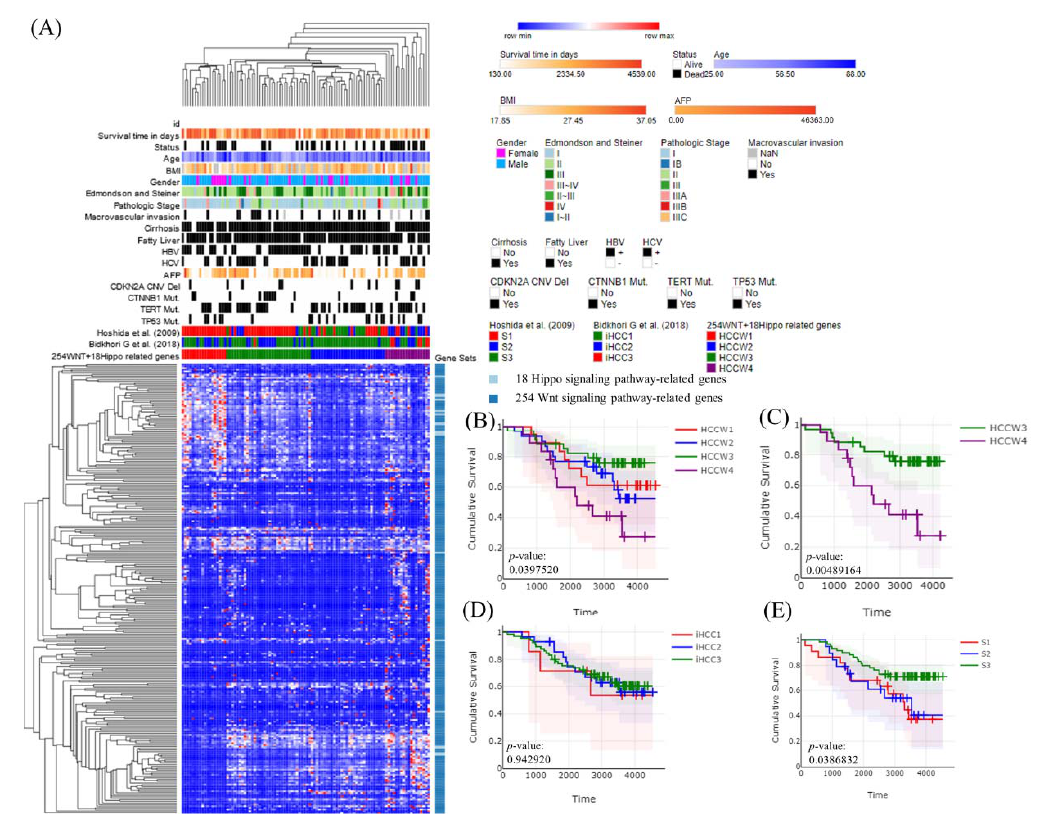
Figure 3. Molecular classification of Taiwanese HCC patients using a panel of 272 Wnt–Hippo pathway genes. ( A ) Heatmap showing normalized expression levels of the 272 signature genes (rows) across subjects (columns) divided into four molecular subclasses (HCCW1–4), where blue and red indicate low and high expression, respectively. Significant differences in demographic characteristics, clinical annotations, molecular subclasses, and hepatitis B and C virus infection status across subjects are shown at the top of the figure. ( B ) Overall survival for subjects in each molecular subclass. ( C ) HCCW3 showed significantly better prognosis than HCCW4 based on two-sided log-rank tests. ( D ) The Bidkhori classification results were not significantly correlated with survival, whereas ( E ) the Hoshida classification results did show a significant correlation.